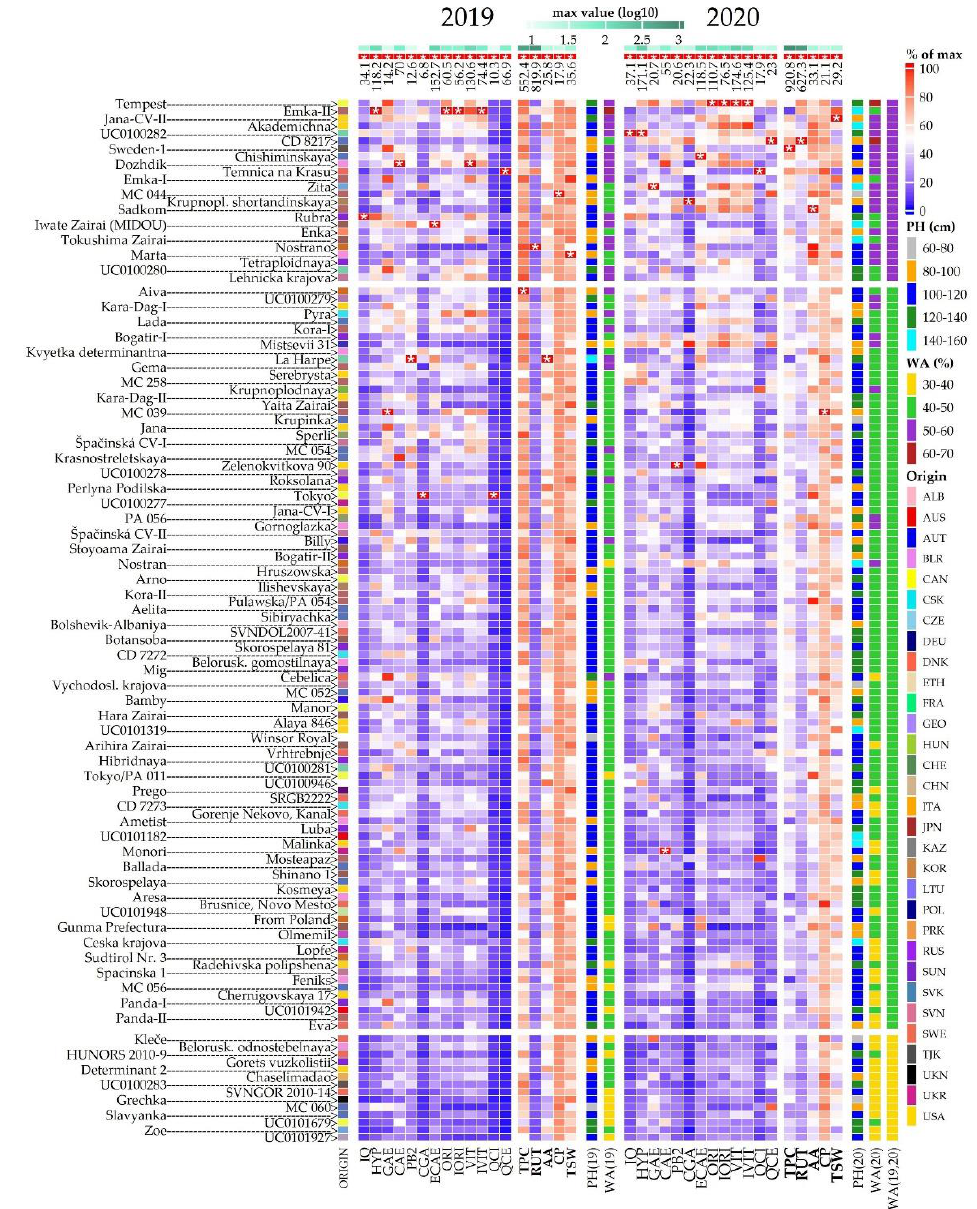
Figure 5. Heatmap showing levels of 19 descriptors (listed below) as observed for the set of 136 buckwheat accessions listed on left side of the plot. Mentioned descriptors comprise Plant height (PH [cm]), Antioxidant activity (AA [mmol TE/g d.w.), thousand seeds weight (TSW[g]), Crude protein (CP [% d.w.]) and content of total polyphenols (TPC [g GAE/kg d.w.]) and selected fractions, namely Isoquercetin (IQ), Hyperoside (HYP), Gallic acid (GAE), Cateching (CAE), Procyanidine B2 (PB2), Chlorogenic acid (CGA), Epicatechin (ECAE), Orientin (ORI), Isoorientin (IORI), Vitexin (VIT), Isovitexin (IVIT), Rutin (RUT), Quercitrin (QCI), Quercetin (QCE), all measured in µg/g d.w. Main heatmap bodies corresponds to values of 18 descriptors (excluding PH) depicted as percentage of maximal value (listed above the heatmap, marked with * ) recorded for respective descriptor in the given year of observation and displayed on a scale from blue (0) to red (100%). Side heatmap contains information about plant heights (PHs) for each accession as well as score based on weighted average (WA) of ratios to maximum values in each descriptor, displayed both on categorical scale. Accessions are sorted according to average score from both years (WA19, 20) and split into three groups with low, medium and upper score. Origin stands for country of origin of respective